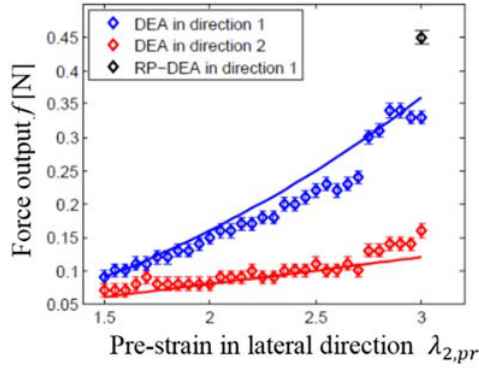
Figure 6. Force measurement results (diamonds) against correlation according to Equation (7) (lines) in direction 1 (blue) and direction 2 (red).